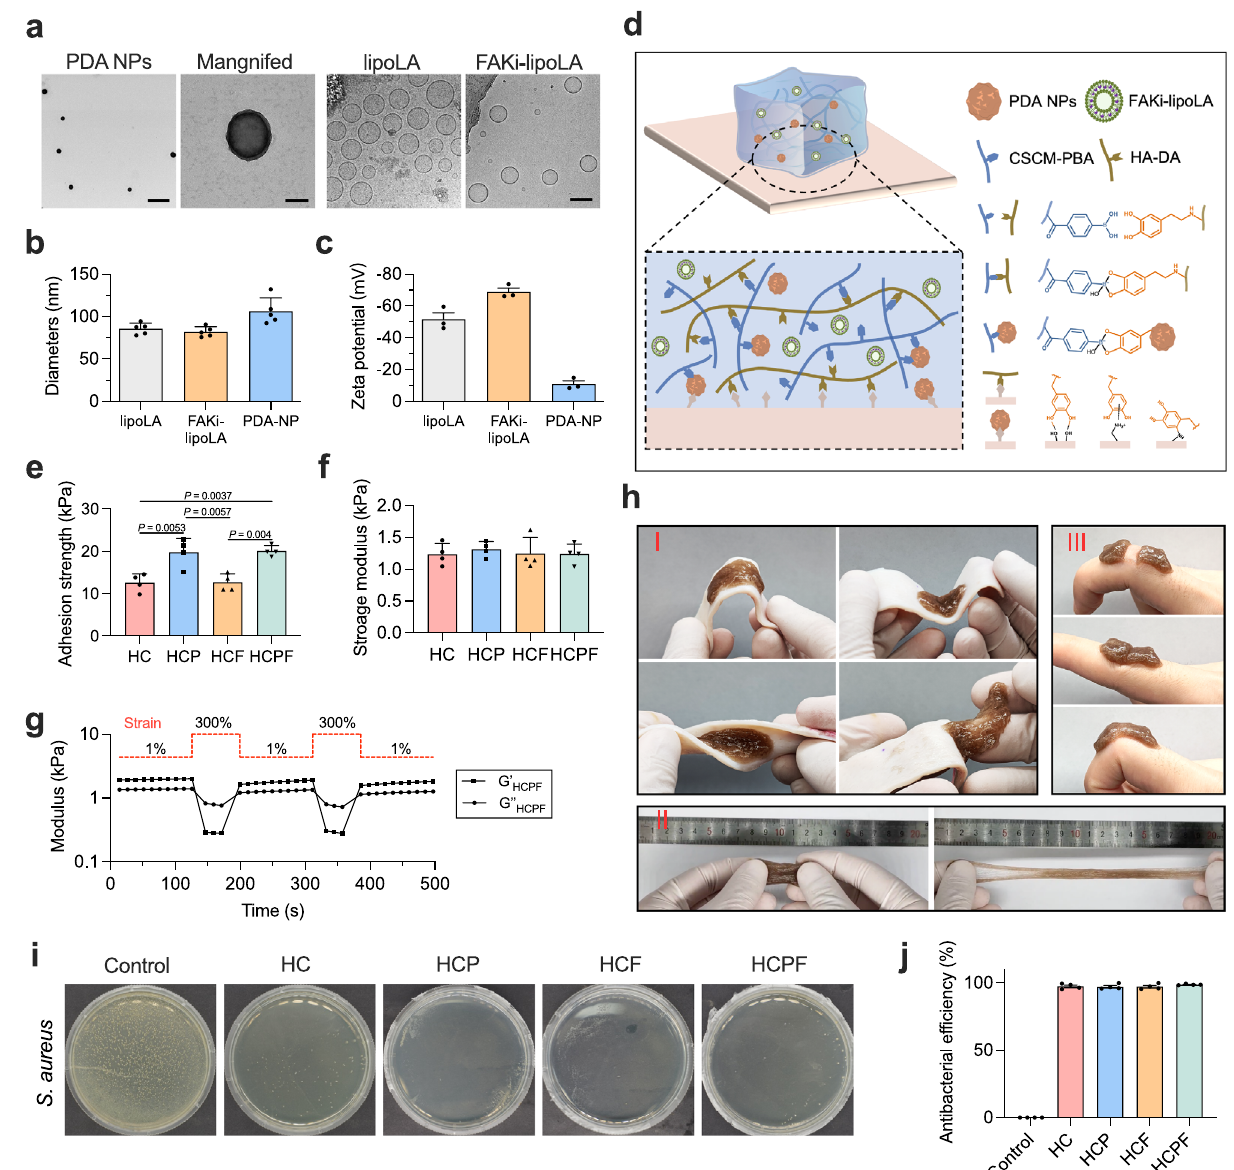
Fig. 3 | Design and characterization of PDA NPs, FAKi-lipoLA, and HCPF hydrogel. a TEM images of PDA NPs and FAKi-LipoLA. Scale bar, 1 μ m and 100nm for the magni fi ed fi eld. n =5 samples with similar results. b Particle diameters cal- culatedfromTEMimagesin( a ). n =5samples.Dataareshownasmean±s.d. c Zeta potential of different particles. n =3 samples. Data are shown as mean±s.d. d Schematic illustration of crosslinking mechanism and adhesive mechanism of hydrogels. e Adhesion strength of different hydrogels on pig skin, n =4 samples. Data are shown as mean±s.d. f Storage modulus of different